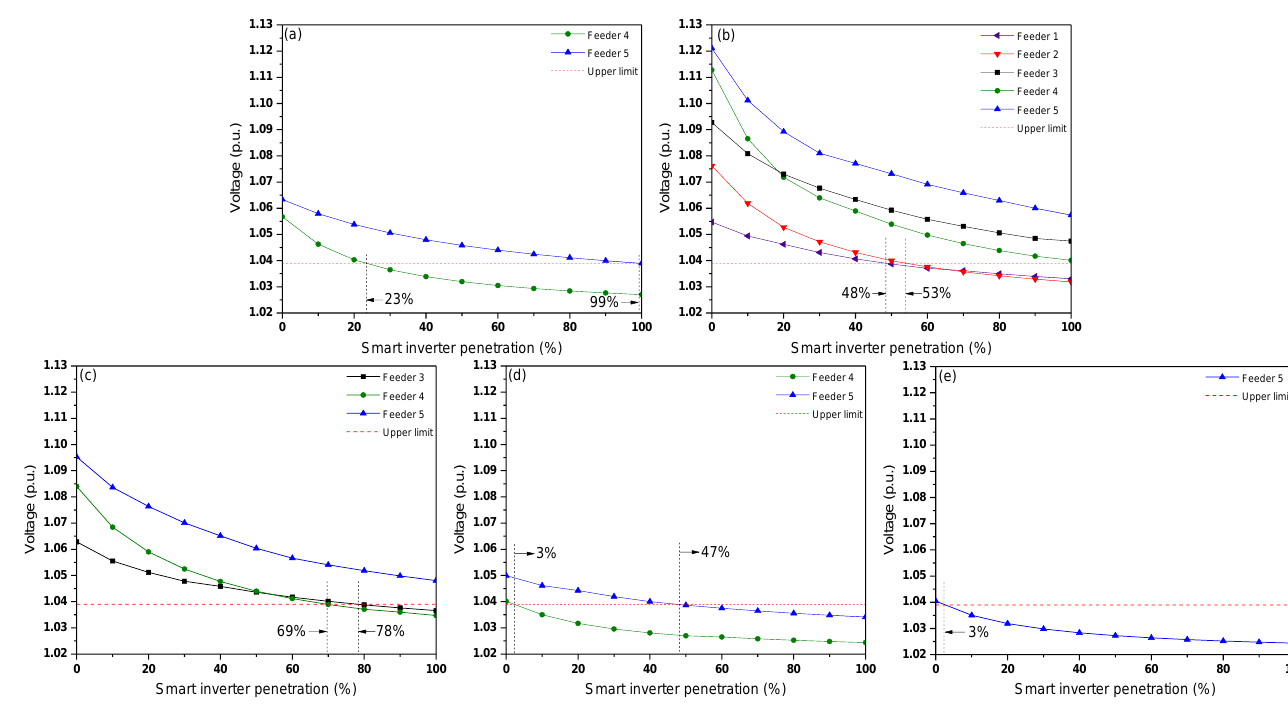
Figure 14. Minimum feeder voltages according to the penetration rate of smart inverters: ( a ) Case 2 and ( b ) Case 5.